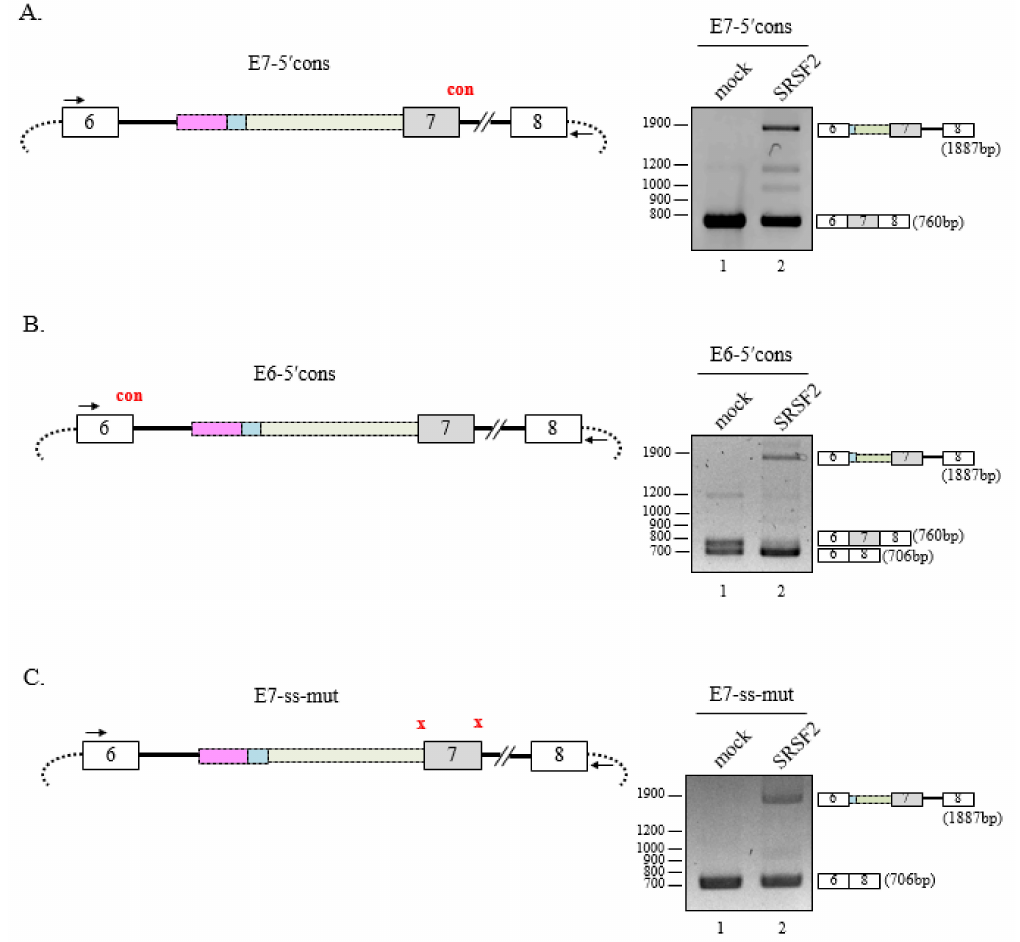
Figure 4. 5 (cid:48) splice-site mutations do not a ff ect SRSF2-mediated 3 (cid:48) AG (cid:48) activation. ( A ) (Left panel) Schematic diagram of the E7-5 (cid:48) cons minigene where the 5 (cid:48) ss has been changed to a conserved sequence. (Right panel) RT-PCR analysis of the E7-5 (cid:48) cons minigene in SRSF2-expressing cells. ( B ) (Left panel) Schematic diagram of the E6-5 (cid:48) cons minigene including the conserved 5 (cid:48) ss sequence of exon 6. (Right panel) RT-PCR analysis of the E6-5 (cid:48) cons minigene in SRSF2-expressing cells. ( C ) (Left panel) Schematic diagram of the E7-ss-mut minigene where the splice signals of exon 7 have been abolished. (Right panel) RT-PCR analysis of the E7-ss-mut minigene in SRSF2-expressing